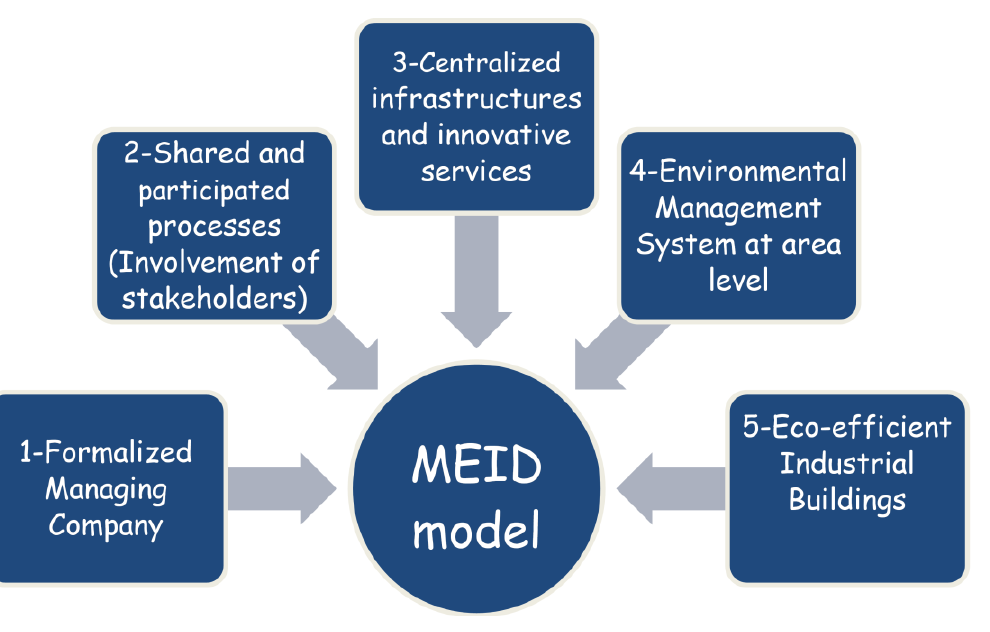
Figure 10. The Mediterranean Eco Industrial Development (MEID)